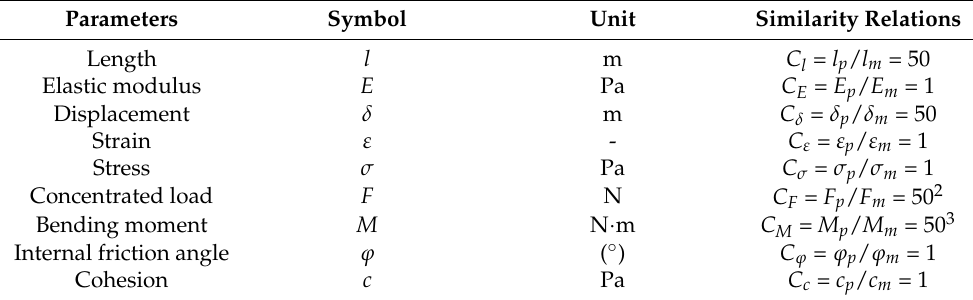
Table 1. Similarity law of the centrifugal model